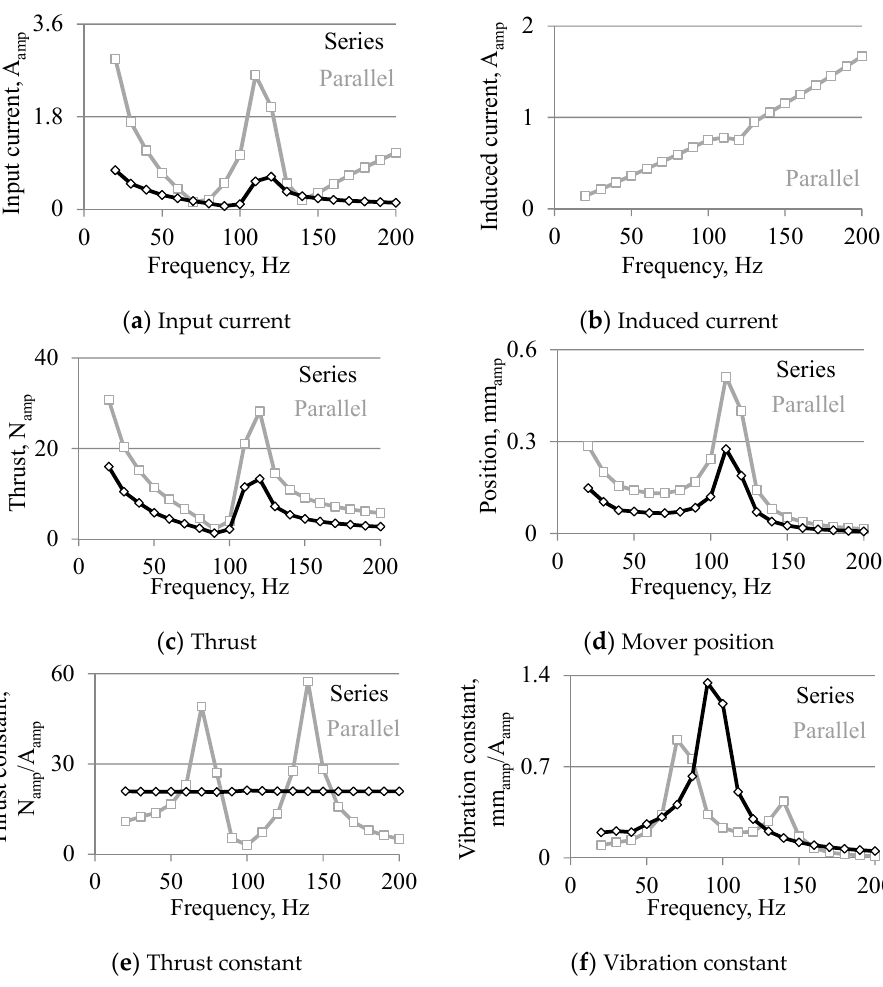
Figure 10. Analyzed results against drive frequency.